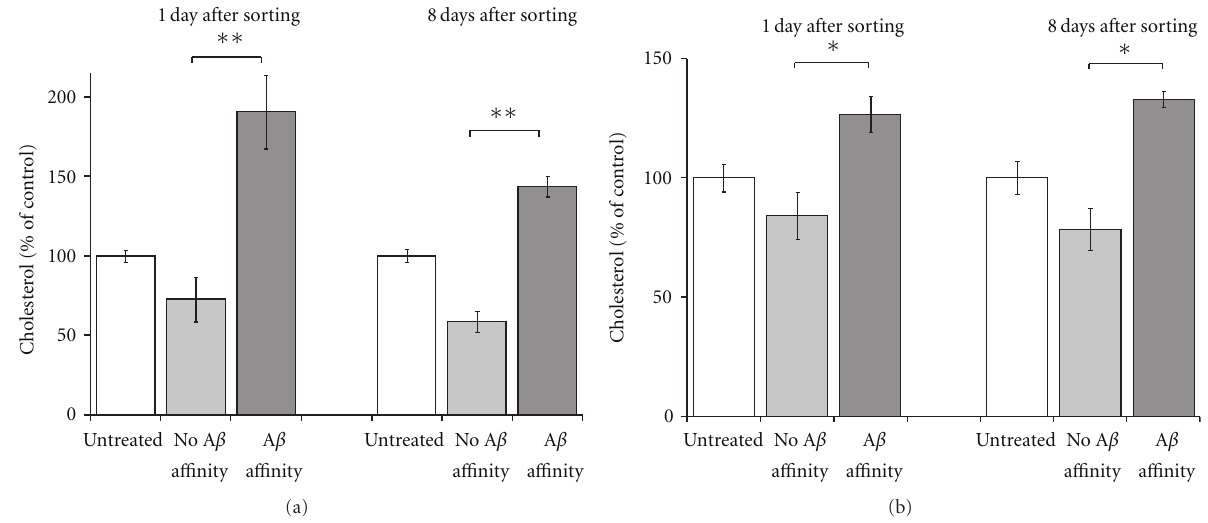
Figure 6: Correlation between A β -FAM binding and the levels of membrane cholesterol observed in cells sorted on the basis of the A β -FAM fluorescence. PC12 cell and hippocampal neuronal cells were exposed for 80 minutes to A β -FAM for binding and then sorted on the basis of the FAM fluorescence. After sorting A β -FAM, treated cells were pooled into two populations: no A β -FAM a ffi nity and A β -FAM a ffi nity. Cells were cultured and allowed to grow and membrane cholesterol levels were measured at 1 and at 8 days after sorting. (a) and (b) show the results for the PC12 cell and hippocampal neuronal cells, respectively. The correlation between the levels of A β -FAM binding and the levels of membrane cholesterol is observed even after 8 days of cell